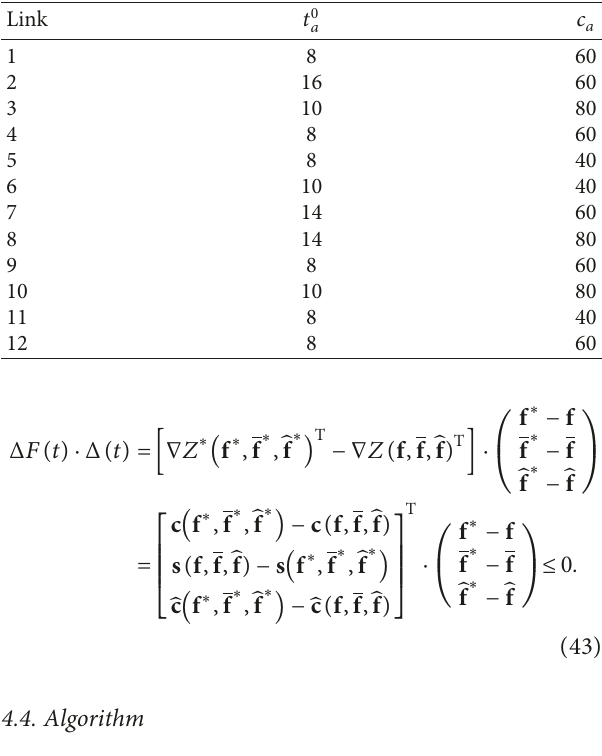
Table 2: Parameters in link travel time